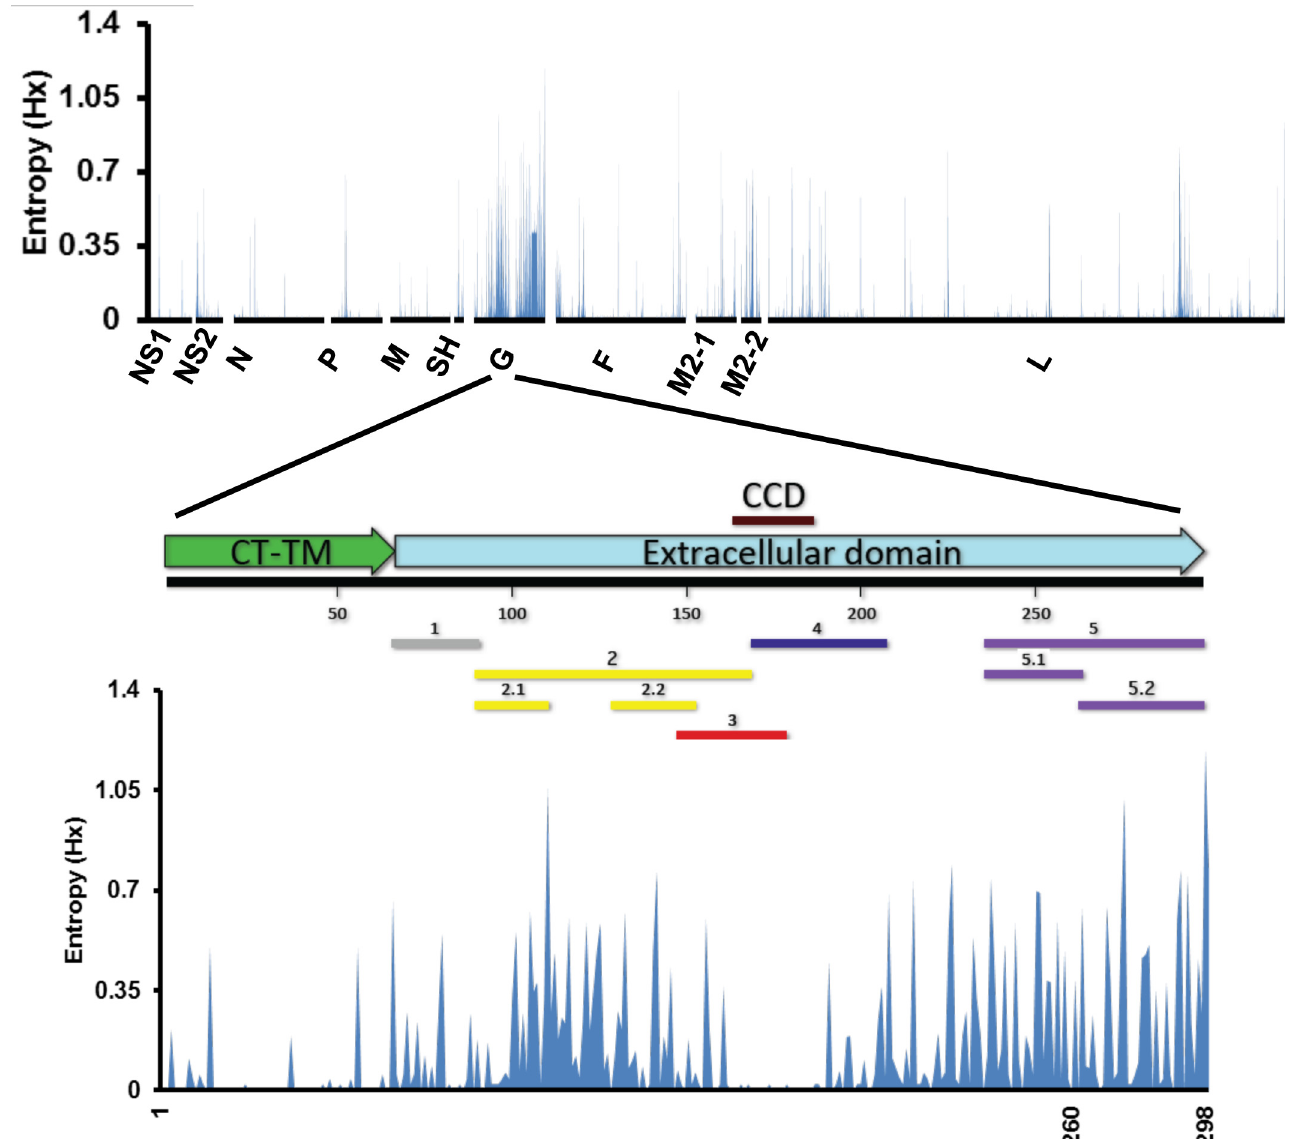
Fig 7. Contribution of anti-G antibody response following RSV primary infection in the evolution of RSV viruses. Accumulation of amino acid variations in RSV protein sequence in human isolates collected from 1979 – 2013. Protein sequences from RSV subtype A human isolates were obtained through the Virus Pathogen Resource (ViPR, http://www.viprbrc.org). 297 isolates with complete genome sequences and non-ambiguous amino acids were included in the analysis. The sequences were aligned using MUSCLE and a consensus sequence was created based on the alignment. The polymorphisms from that consensus were then scored by calculating the entropy (Hx) using Bioedit. Entropy scores are represented in the Y-axis and the RSV proteins in the X-axis. Alignment of antigenic sites in RSV-G identified using GFPDL approach with sequence variability scores in the RSV-G protein is shown the bottom